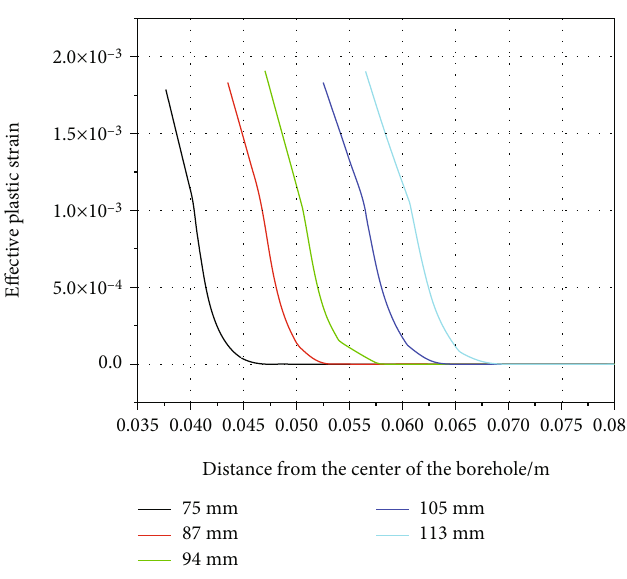
Figure 6: E ff ective plastic strain of di ff erent pore sizes.